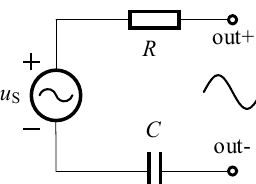
Figure 9. Lumped port external circuit. The electromagnetic field simulation diagram by FEM of the DWPT is shown in Figure 10. In the electric field distribution simulation diagram, the electric field is concen- trated at the coupling point of the power receiving device and the power supply desktop, and the electric field radiation in other spaces is weak. The electric field strength of the resonant coil on the left and the resonant plane coil in the middle is weak, and the electric field strength is the strongest at the metal film of the receiving device. The metal